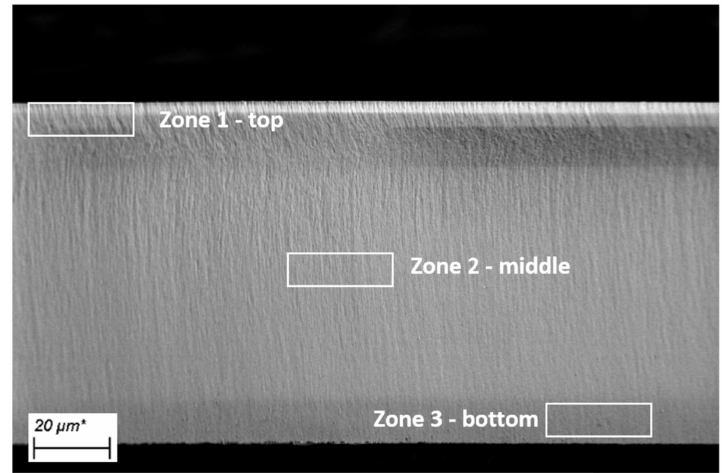
Figure 3. Scanning electron microscopy (SEM) cross-section image of a multi-layered porous silicon membranes, showing the zones defined for Energy Dispersive X-ray Spectroscopy (EDX).